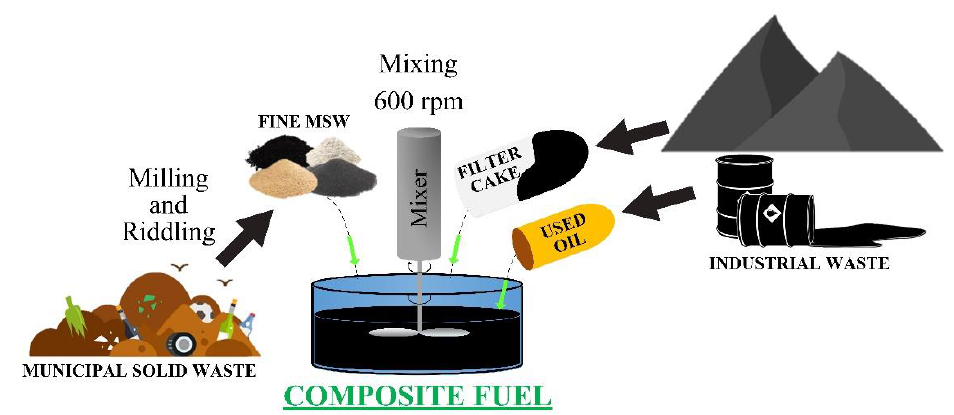
Figure 1. Scheme of fuel slurry preparation.